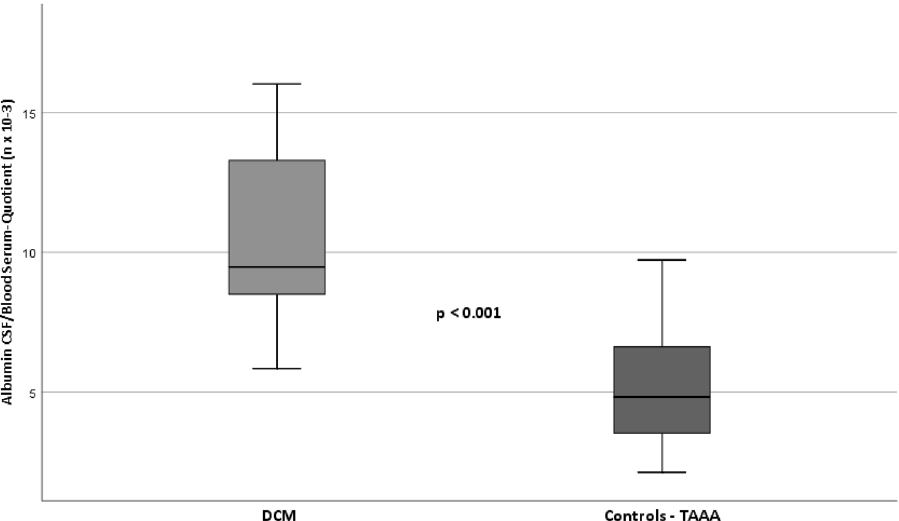
Figure 2. Significant differences of Albumin CSF/Blood Serum-quotients (AlbuminQ n × 10–3) between DCM and controls, as sign of blood spinal cord barrier disruption in DCM patients. CSF cerebrospinal fluid, DCM Degenerative cervical myelopathy, TAAA thoracic aortic abdominal aneurysm. Italic values indicate significance level of p <